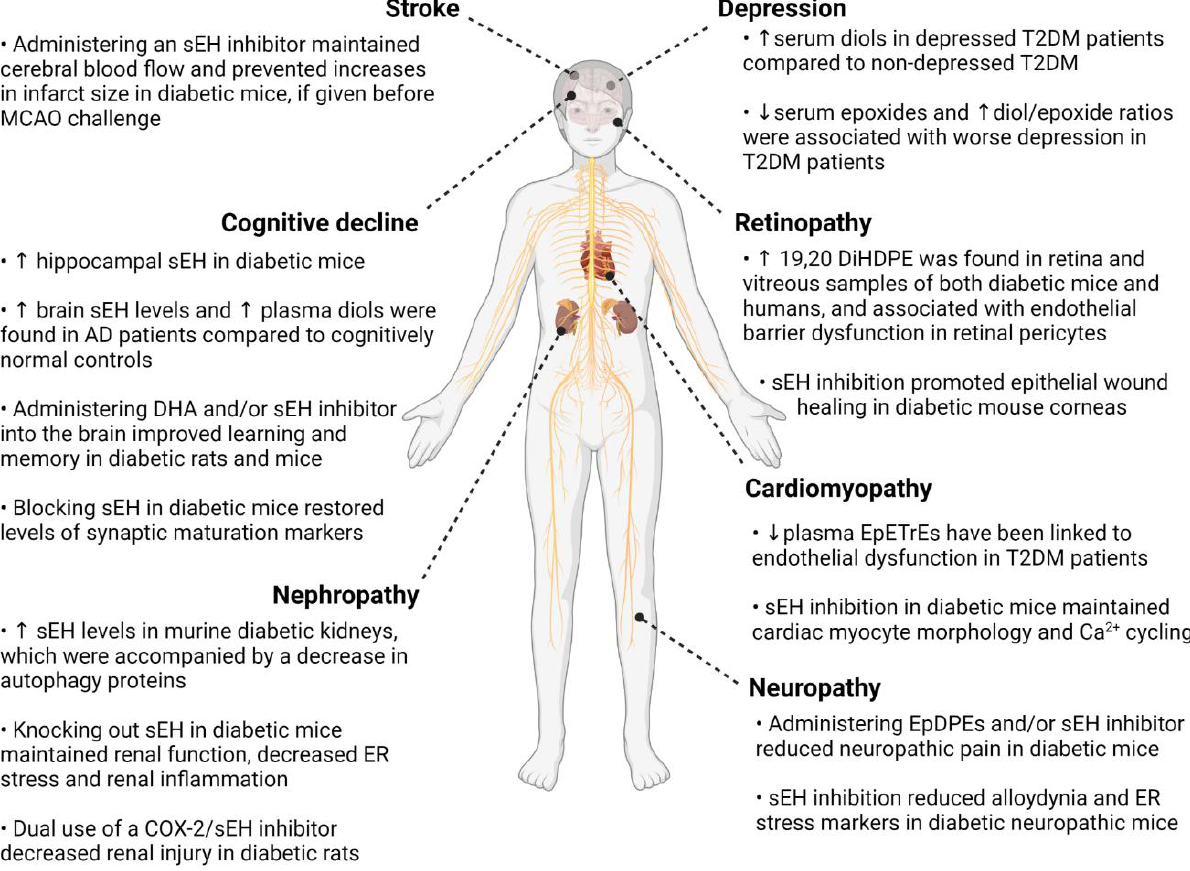
Figure 2. A summary of the animal and clinical literature on the cytochrome P450-soluble epoxide hydrolase (CYP450-sEH) oxylipin pathway and type 2 diabetes mellitus (T2DM) complications. Abbreviations: MCAO, middle cerebral artery occlusion; AD, Alzheimer’s Disease; DHA, docosahexaenoic acid; ER, endoplasmic reticulum; COX-2, cyclooxygenase-2; 19,20-DiHDPE, 19,20-dihydroxy-docosapentaenoic acid; EpETrE, epoxyeicosatrienoic acid. Created with BioRender.com.